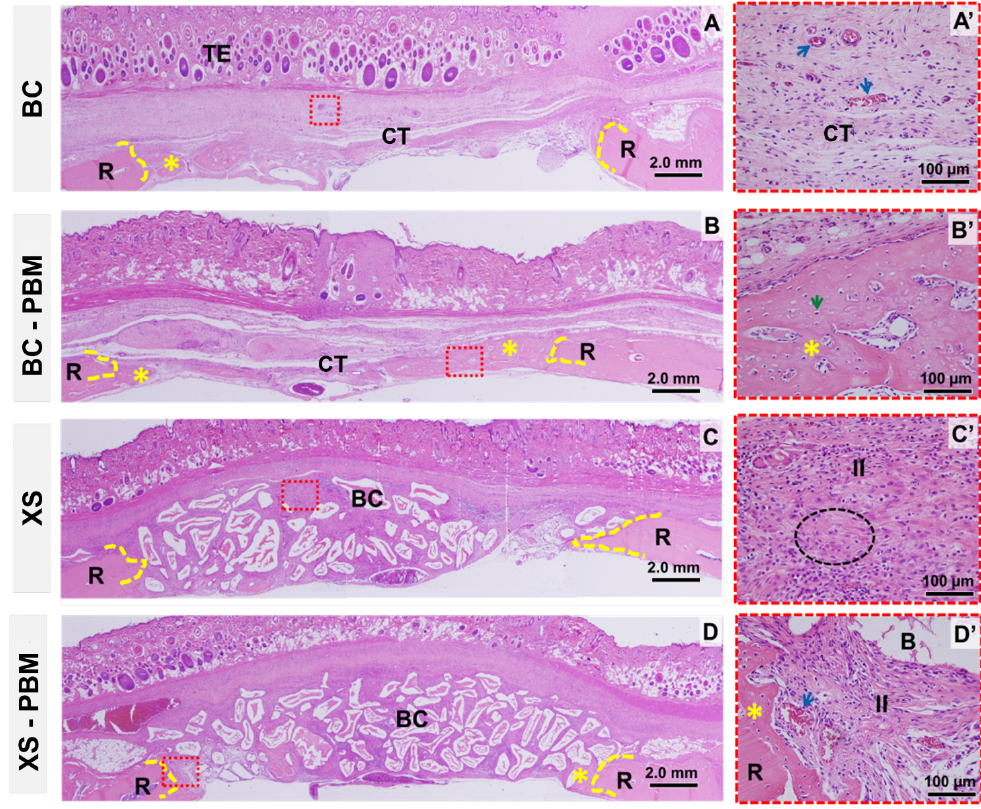
Figure 5. Histological images of critical size defects in rat calvaria within 14 days, coronal histological sections. (A) Blood clot group – BC; (B) blood clot with PBM group – BC-PBM; (C) xenogeneic bone graft + fibrin biopolymer scaffold group – XS; (D) xenogeneic bone graft + fibrin biopolymer scaffold with PBM group – XS- PBM. R: Remaining bone; TE: tegument; CT: connective tissue; BC: biocomplex biomaterial with fibrin biopolymer. B: Bio-Oss TM particle; II: inflammatory infiltrate. Dotted yellow line: border; asterisk: bone neoformation; red dotted square: highlighted area; green arrow: osteocyte; blue arrow: blood vessel; black dotted circle: collagen fibers with scattered orientation. HE staining. (A-D) 4x lens, bar = 2 mm. (A’-D’) enlarged 40× images, bar = 100